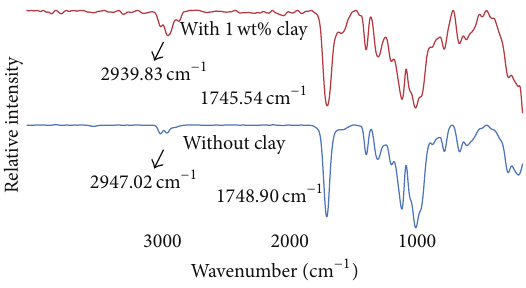
Figure 1: FTIR spectra of PLA/PCL/OPMF biocomposites and PLA/PCL/1wt% clay/OPMF hybrid